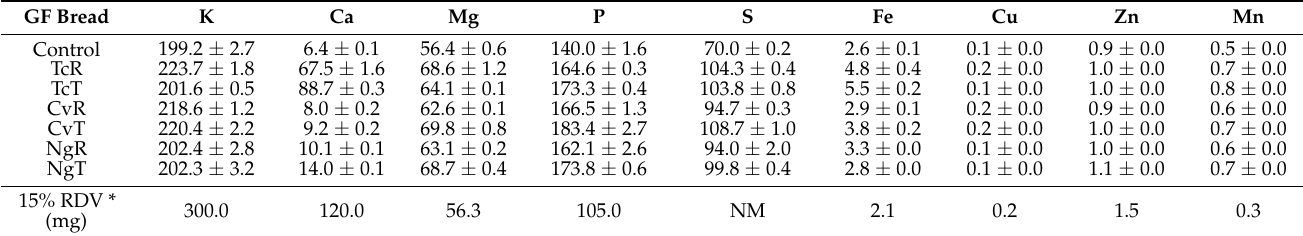
Table 5. Influence of 4% microalgae replacement on mineral content (mg/100 g) of the gluten-free bread (n = 2, wet basis). Tetraselmis chuii (TcR), Tetraselmis chuii ethanol-treated (TcT), Chlorella vulgaris (CvR), Chlorella vulgaris ethanol-treated (CvT), Nannochloropsis gaditana (NgR), and Nannochloropsis gaditana ethanol-treated